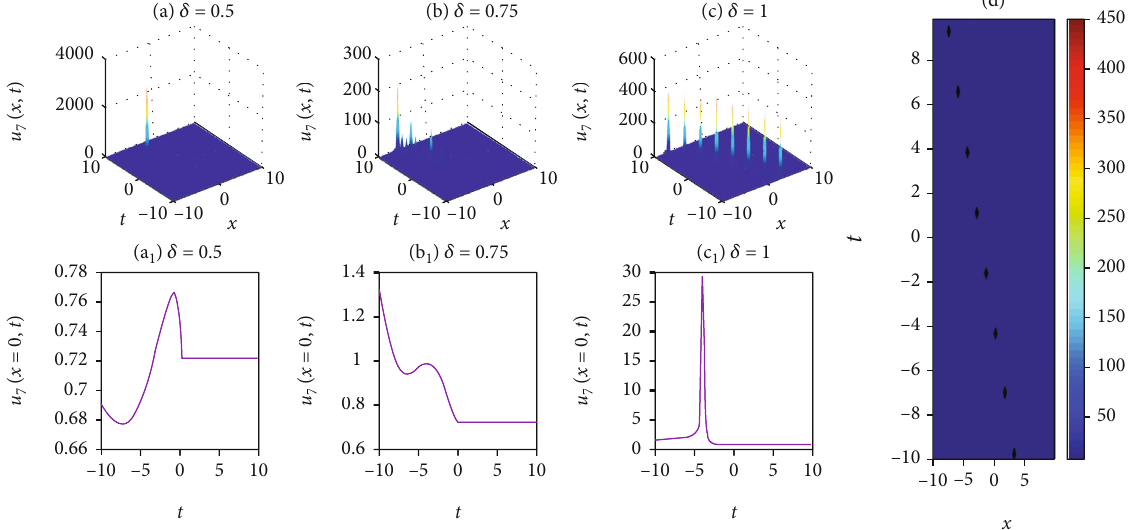
ð x , t Þ . (a – c) 3D plots. (a 7